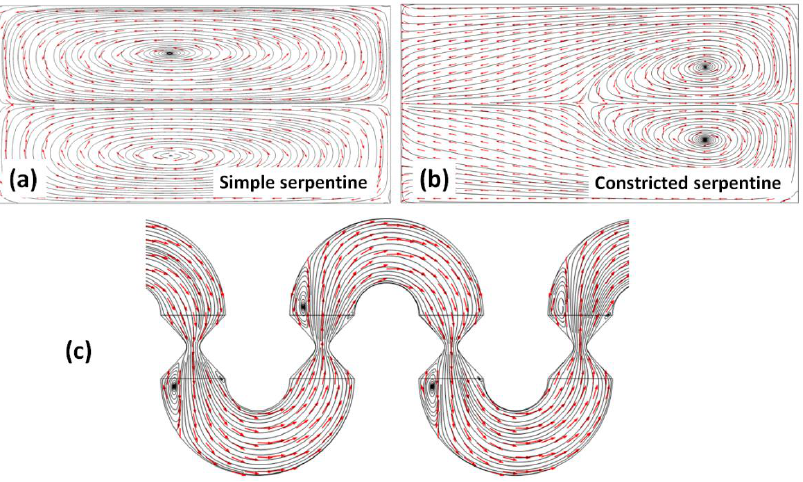
Figure 8. Streamline plots for: ( a ) transversal section in a serpentine channel; ( b ) transversal section in a constricted channel; and ( c ) longitudinal section in a constricted channel ( Re = 40).